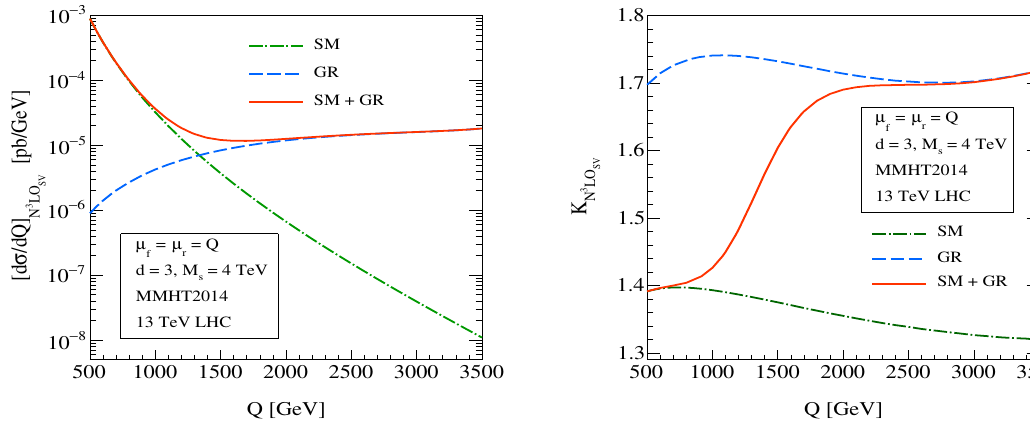
Figure 2 . The invariant mass distribution (left panel) of di-lepton pair at center of mass energy 13 TeV LHC for SM, ADD (GR), signal (SM+GR) and the corresponding K factors (right panel) at N 3 LO sv level.